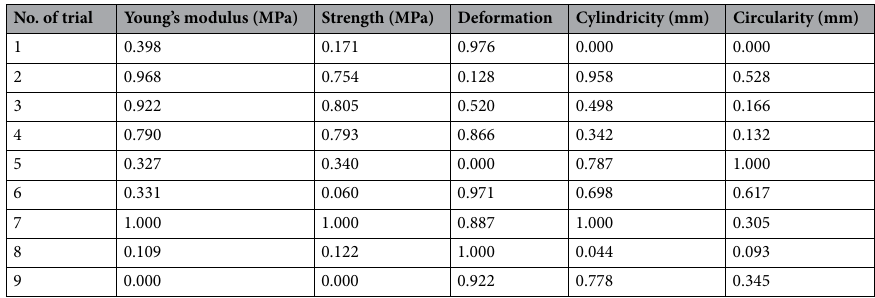
Table 6. Deviation sequence of GRA.